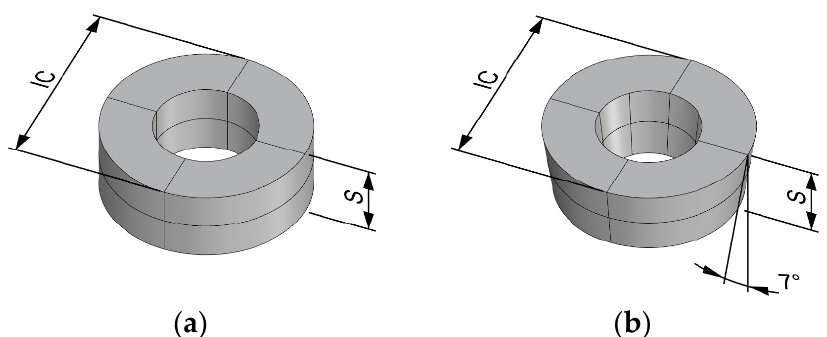
Figure 2. Round inserts produced by Sandvik Coromant [33]: ( a ) T-Max ® P system RCMX type (IC = 10, 12, 16, 20, 26, 32 mm); ( b ) CoroTurn ® 107 system RCMT type (IC = 05, 06, 08, 10, 12, 16, 20, 25, 32